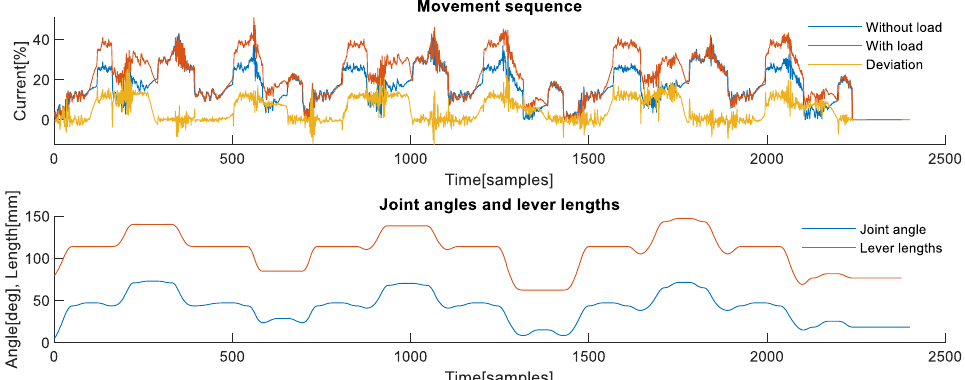
Figure 3. Signals obtained during the manipulation task from the 2nd axis. ( Upper ) Measurements of joint currents while the robot was performing the task without load and with the load. The difference between the two signals represented corresponds to the deviation profile originating from unmodelled dynamics of the contact task. Samples of deviation signal from each axis are one of the inputs to the proposed algorithm. ( Lower ) Measurement of the joint angle is one of the inputs to the proposed algorithm. The algorithm calculates equivalent lever lengths in each sample based on DH parameters and joint angles from all axes.